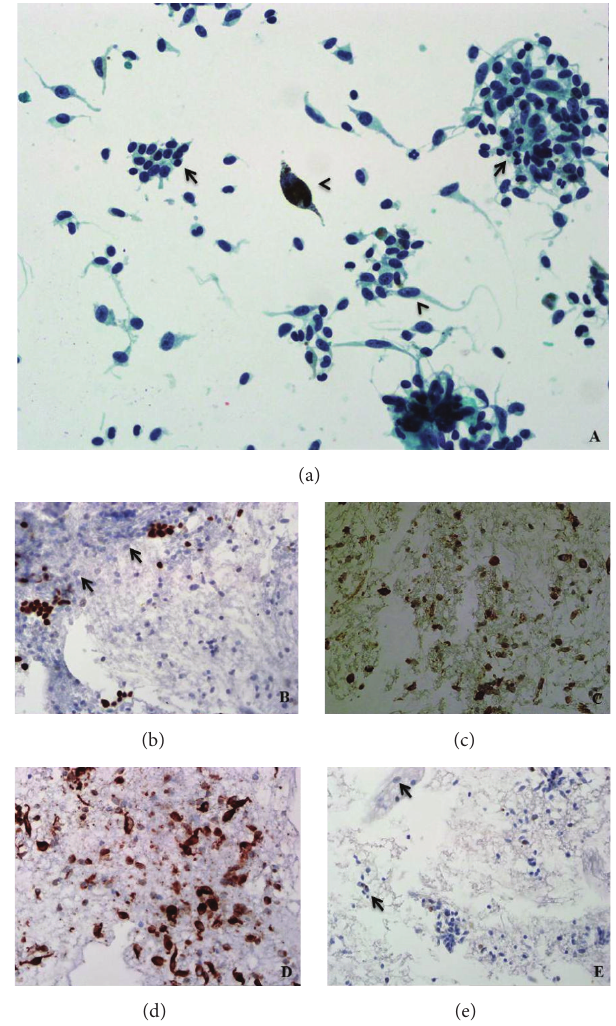
Figure 3: (a) Spindle and epithelioid malignant melanoma cells (arrowheads) admixed with background residual thyroid follicular cells (arrows). Papanicolaou stain, original magnification × 400. (b) TTF-1 highlights residual thyroid follicular cells and is negative in the lesional cells (arrows). TTF-1 ICC, original magnification × 200. (c) HMB45 and (d) MelanA ICC show strong positivity in the lesional cells. Original magnifications × 200. (e) S100 ICC weakly highlights the fine intracytoplasmic pigment present in the lesional cells (arrows). Original magnification × 100.